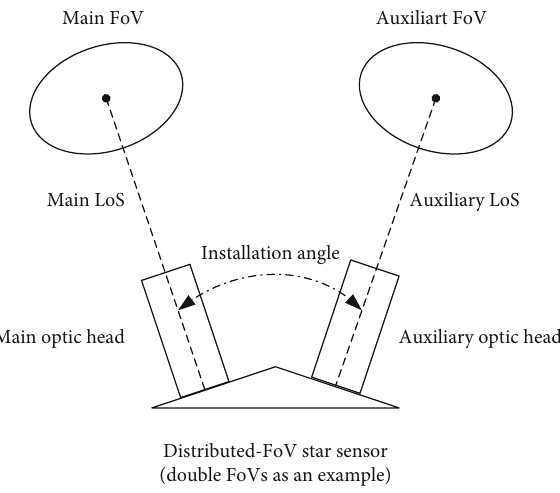
Figure 1: Diagram of a distributed multi-FoV star sensor